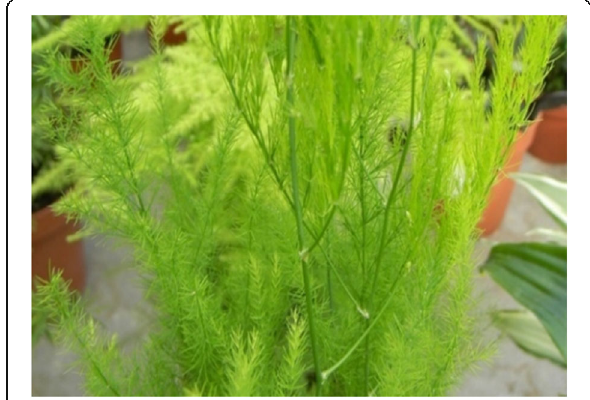
Fig. 1 Image of Asparagus flagellaris